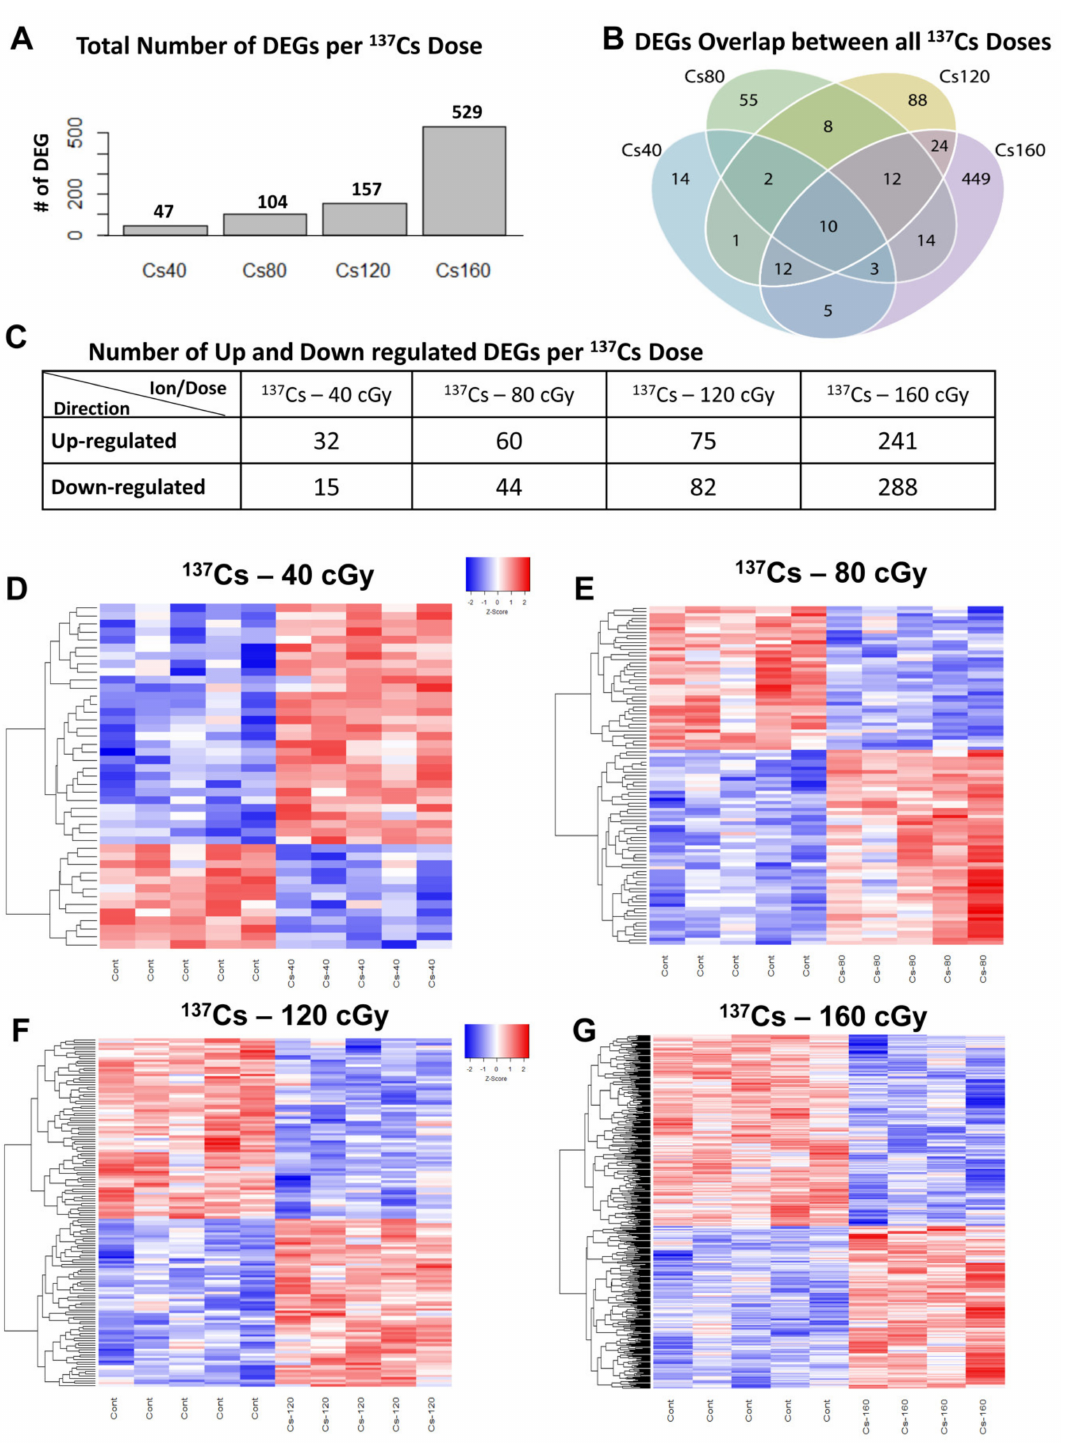
Figure 1. Different gene expression in mouse heart tissue following 137 Cs-gamma irradiation: ( A ) bar graphs showing differentially expressed genes in the mouse heart tissue at different 137 Cs (Cs, cesium) doses and ( B ) Venn diagram depicting the number of differentially expressed genes in the mouse hearts across different doses of 137 Cs irradiation. Colors in the diagram represent genes putatively affected by the following 137 Cs dose exposure: blue circles correspond to 40 cGy, green circles to 80 cGy, yellow circles to 120 cGy, and purple circles to 160 cGy. ( C ) Table depicting the number of up- and downregulated genes at different 137 Cs-IR doses in the heart tissue and ( D – G ) heat maps showing differentially expressed genes at different 137 Cs-IR doses. Relative expression values are indicated on the color key and increase in value from blue to red ( n =